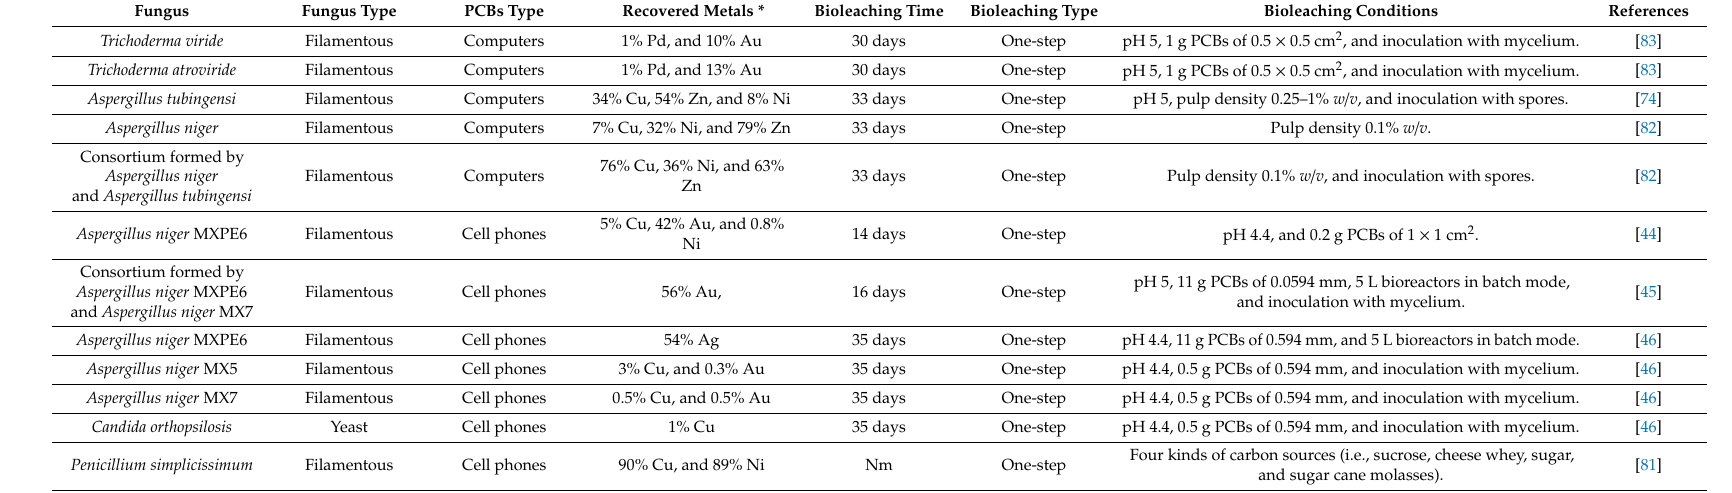
Table 3. Fungi used in the recovery of metals from PCBs of computers and cell